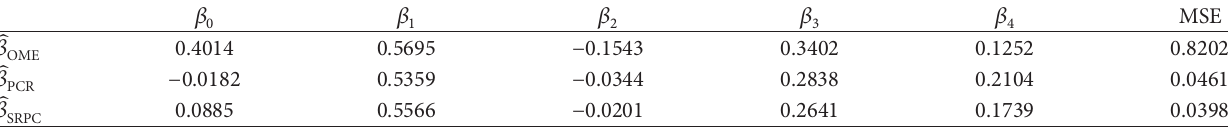
Table 1: Estimated MSE values of the OME, PCR, and